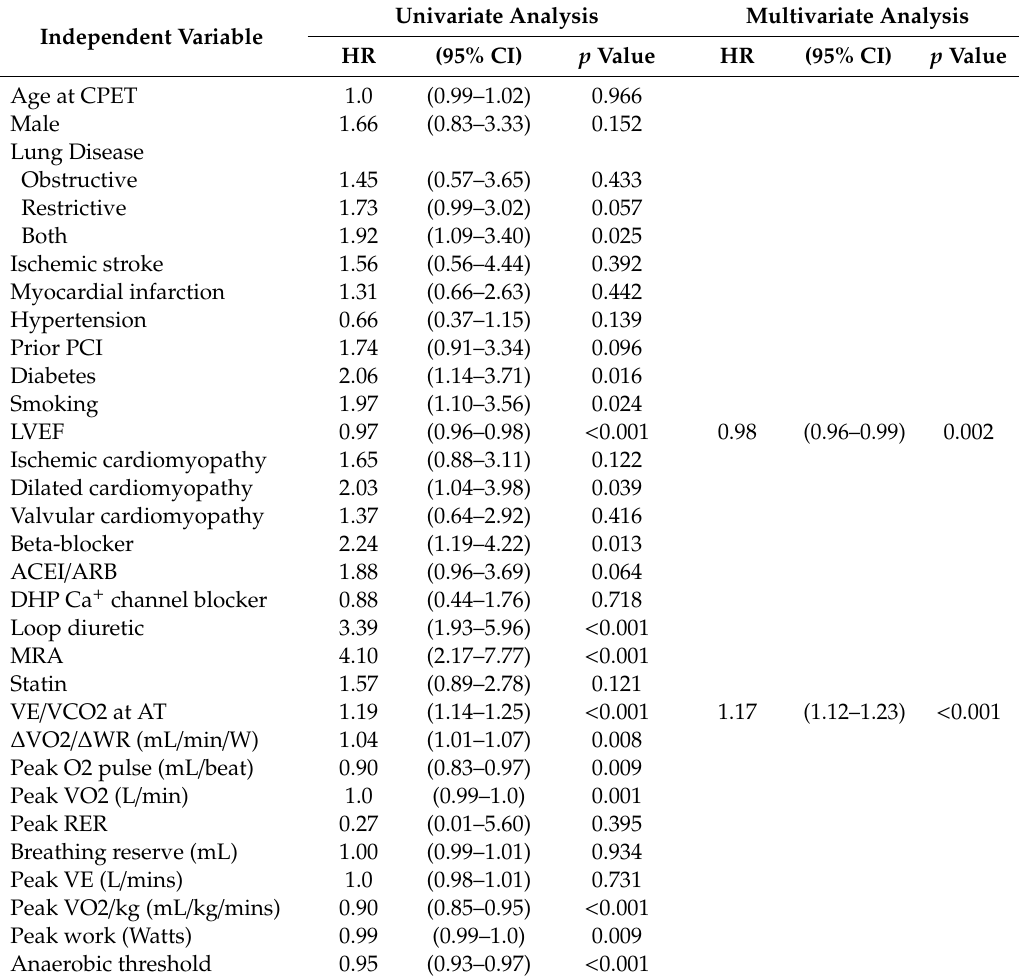
Table 3. Univariate and multivariate analysis of predictors of major cardiovascular